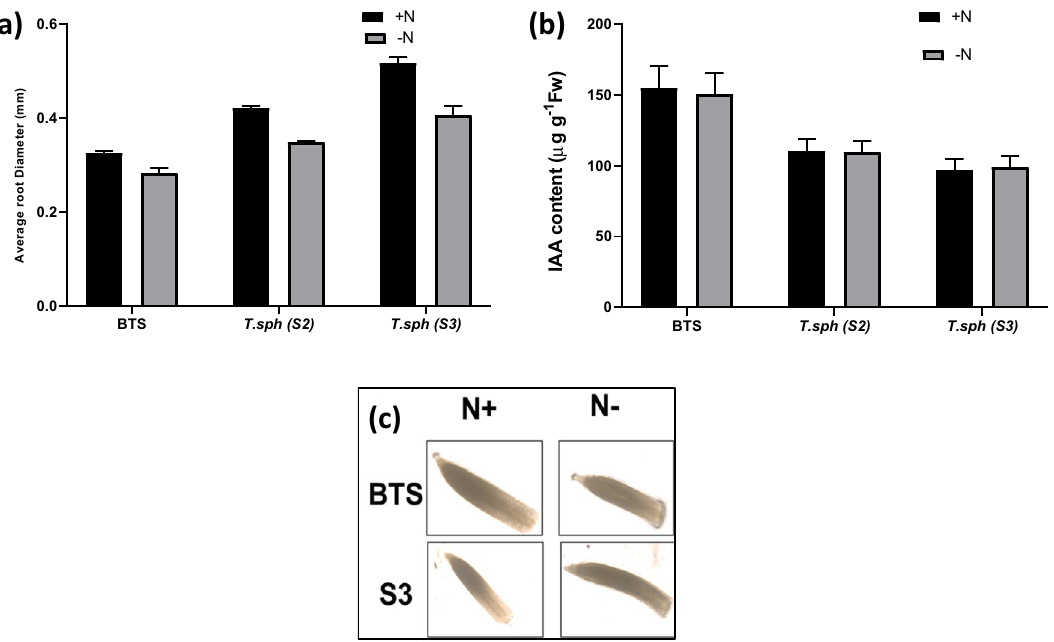
Figure 5. Effect of nitrogen deficient (0.05 mM nitrate, N−) and nitrogen sufficient (7.5 mM nitrate, N+) conditions on average root diameter ( a ), IAA content ( b ) and IAA localization in root tips ( c ) of thirty days old seedlings of wheat genotypes grown under hydroponic culture.